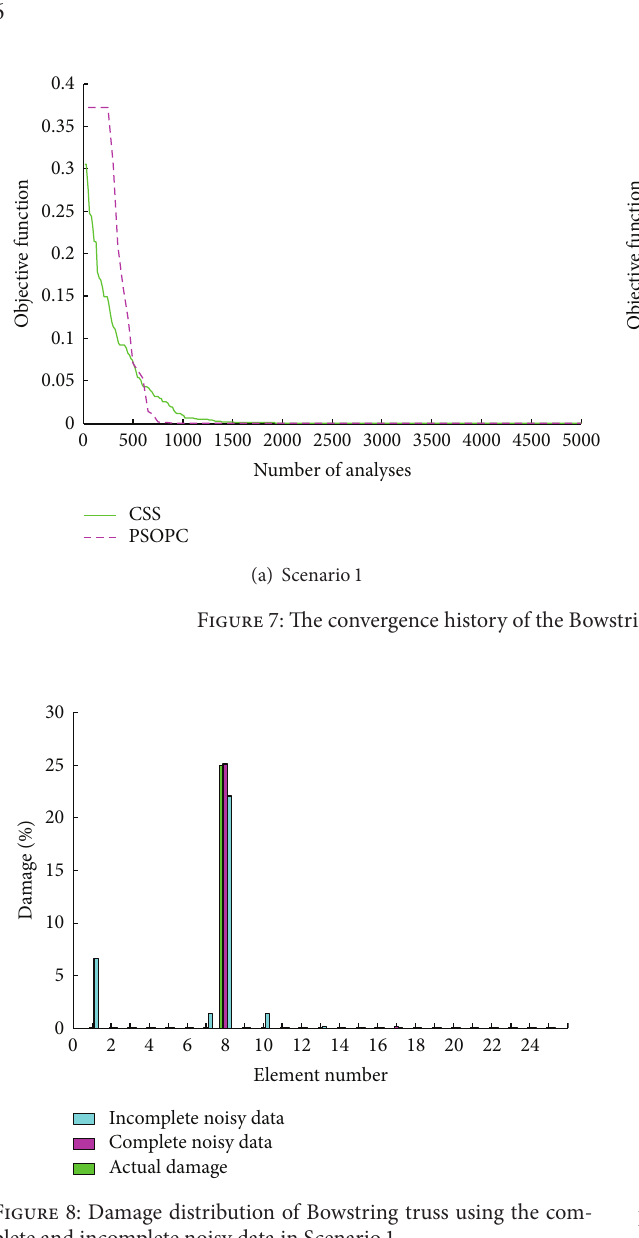
Figure 9: Damage distribution of Bowstring truss using the com- plete and incomplete noisy data in Scenario 2.